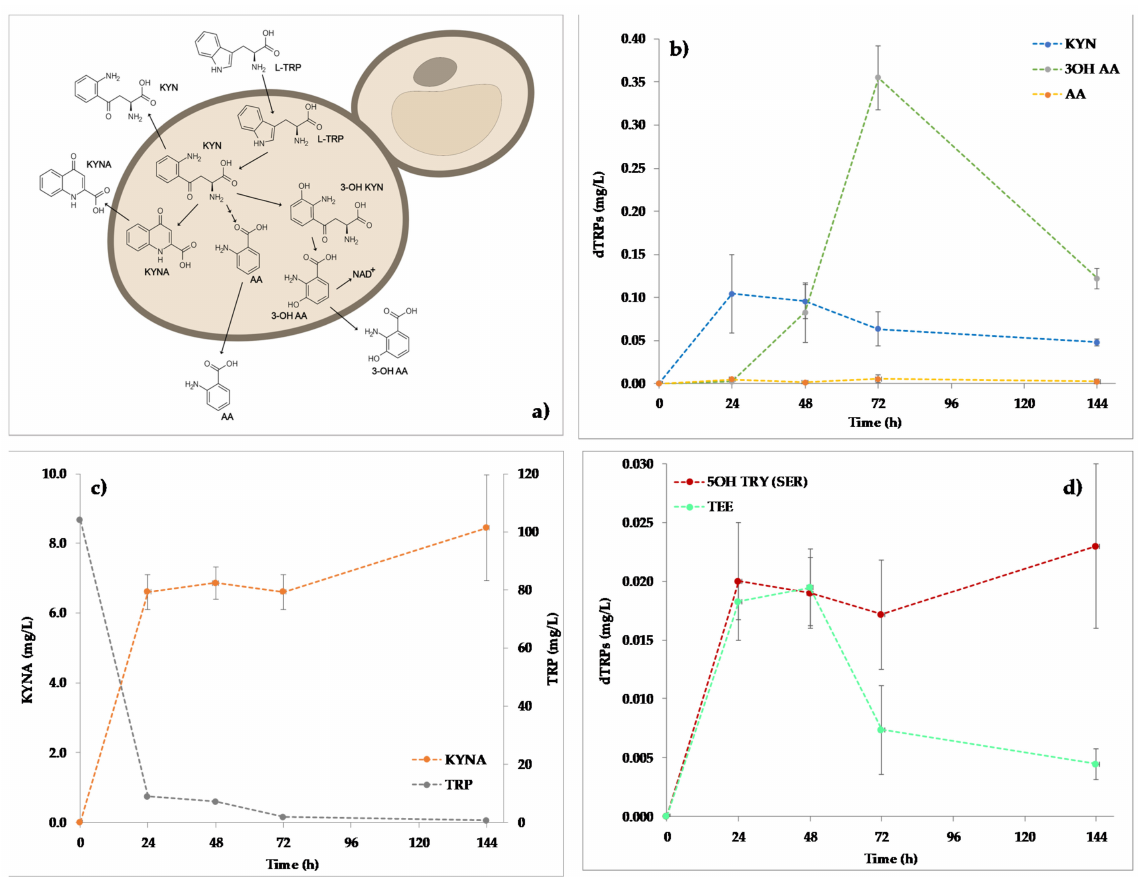
Figure 2. ( a ) Schematic view of the metabolites from the KYN pathway accumulated in YNBT100 medium and ( b , c ) kinetics production of the extracellular intermediates of the KYN pathway in S. cerevisiae EC1118. ( d ) Kinetics production of the extracellular intermediates of the MEL pathway in S. cerevisiae EC1118 in